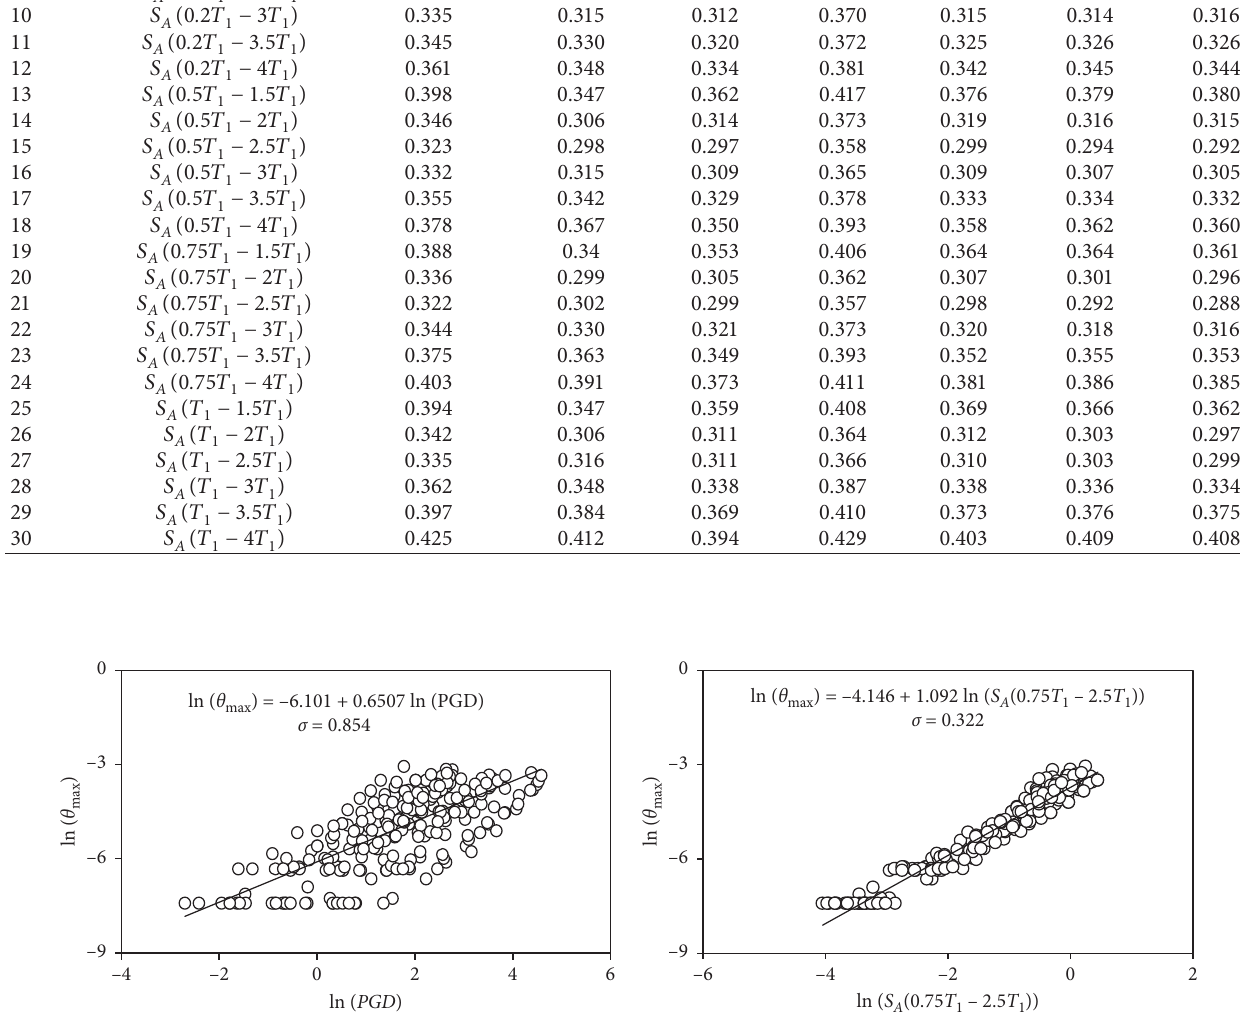
( 0 . 75 T − 2 . 5 T ) . A 1 1